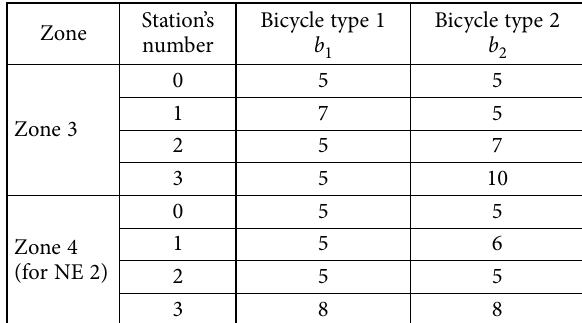
Table 5. The distance (cost of traveling) between zones for NE 1